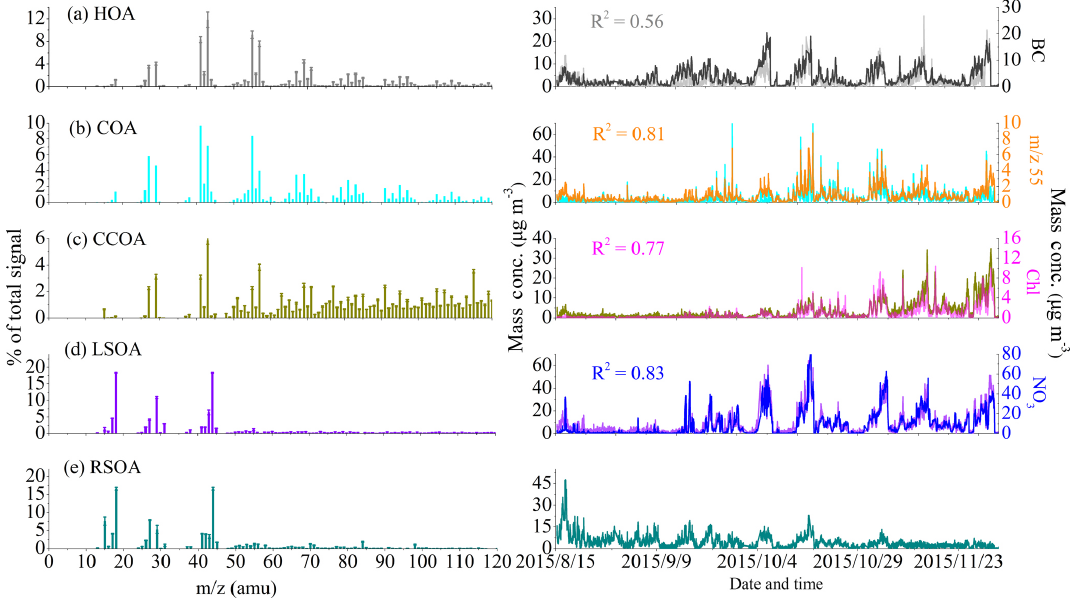
Figure 2. Mass spectra (left) and time series (right) of five resolved OA factors. Error bars of mass spectra represent the standard deviation of each m/z over all accepted solutions. The time series of BC, m/z 55, chloride and nitrate are shown for